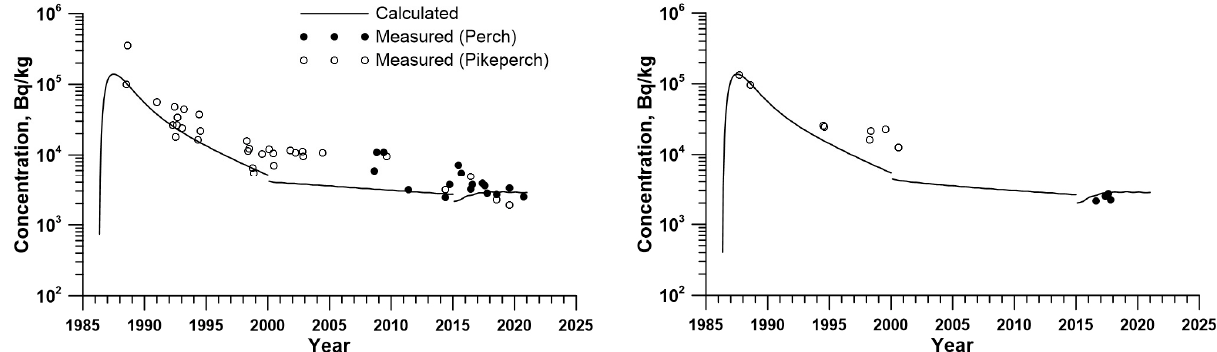
Figure 4. Comparison of calculated and measured concentrations of 137 Cs in non-predatory (prey) fi sh in Sector 1 (left) and Sector 7 (right) of the CP.